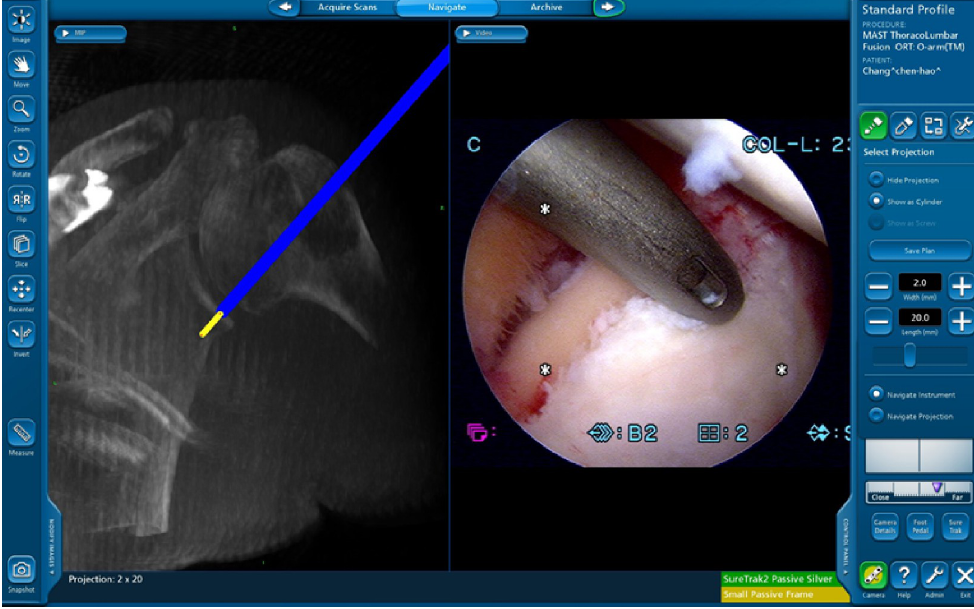
Fig 3. Anchoring and angle of insertion. The depth of the anchors and angle of insertion can be visualized to ensure the best purchase of the suture anchor and to avoid penetration of the contralateral far